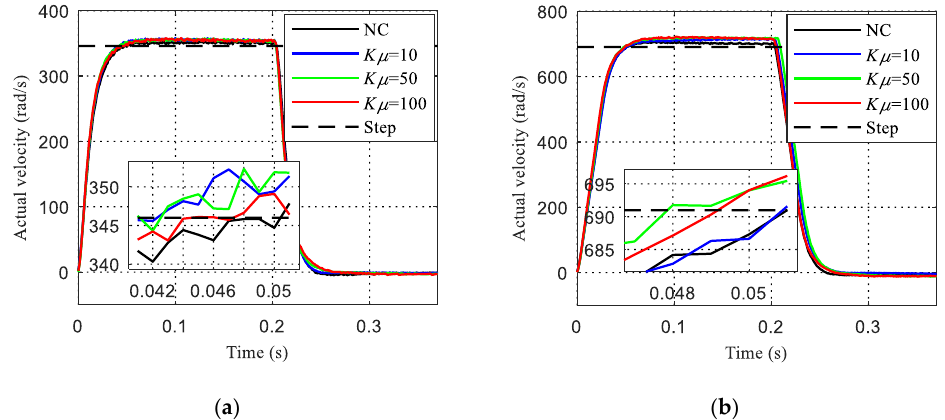
Figure 6. Motor low- and high-velocity step experiments with friction compensation for different gain coefficients ( K μ ) . NC denotes no friction compensation. ( a ) Low-velocity experiment. ( b ) High-velocity experiment.